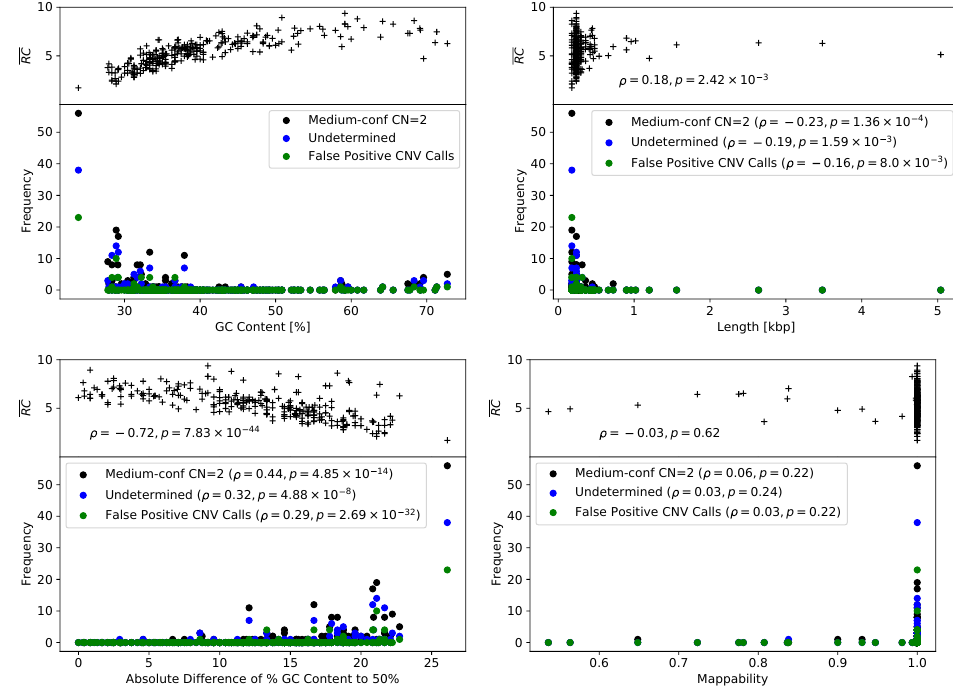
Figure 3. Read abundances and Sophia Genetics DDM outcome depending on target region characteristics. Averaged read abundance per target region ( RC ; see Section 4.6) and counts of medium-confidence normal copy number, undetermined, and false positive predictions of the Sophia Genetics DDM Software dependent on (upper left) GC content, (lower left) absolute difference of GC ratio to 50%, (upper right) target length, and (lower right)